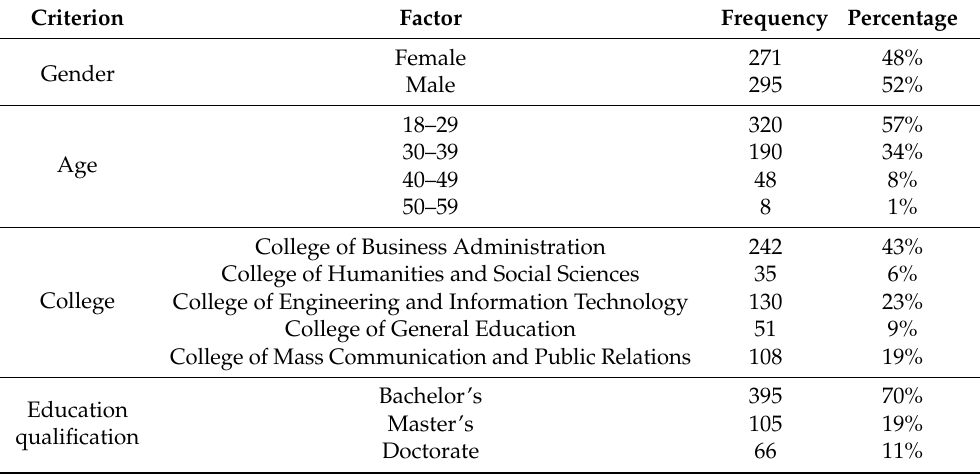
Table 3. Respondents’ demographic